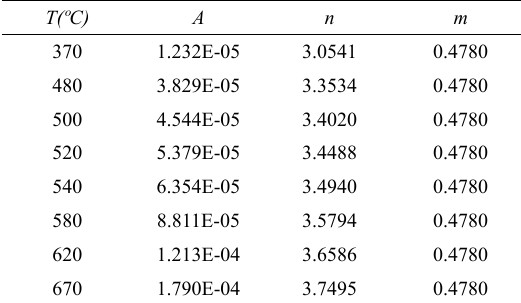
Table 1. Norton-Bailey constants for copper.